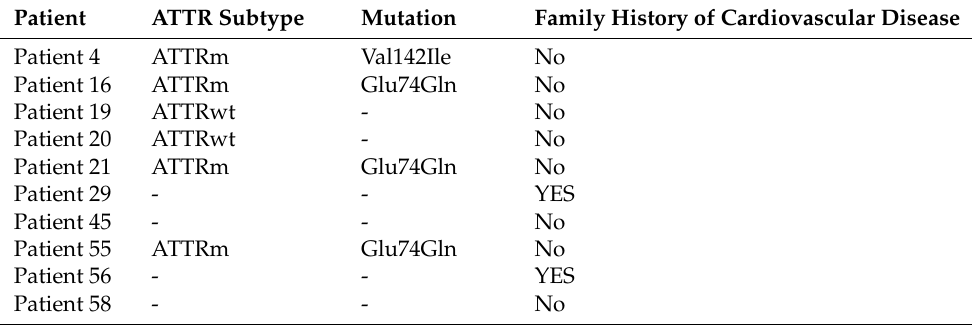
Table 5. Family history of cardiovascular disease for the ATTR positive patients.